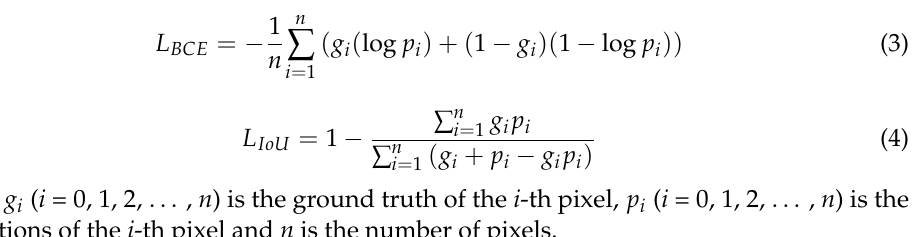
Figure 4. Global attention module (FC means a fully connected layer).